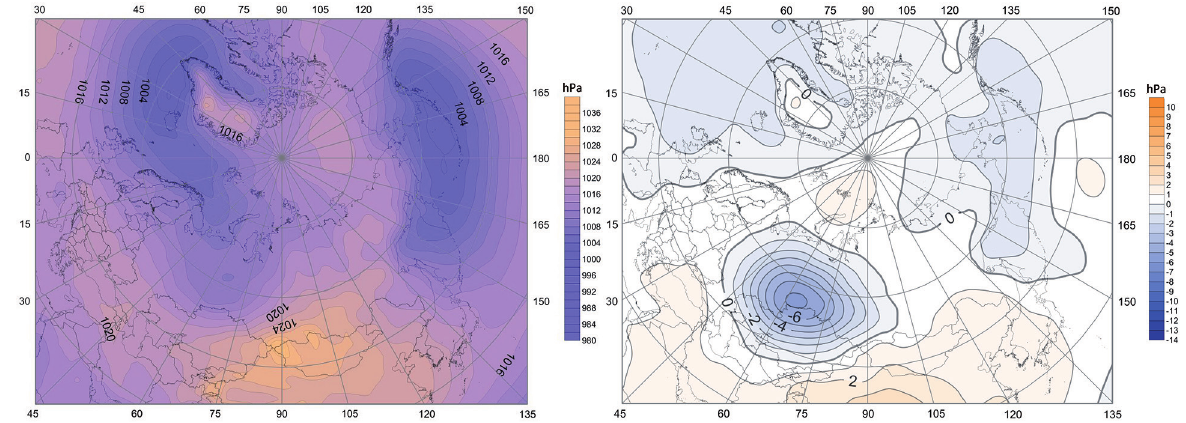
Fig. 4. Mean SLP (left) and anomalies (right) during the days with intensive snowfall, ie., with snow cover increases by at least 5 cm in at least two stations.